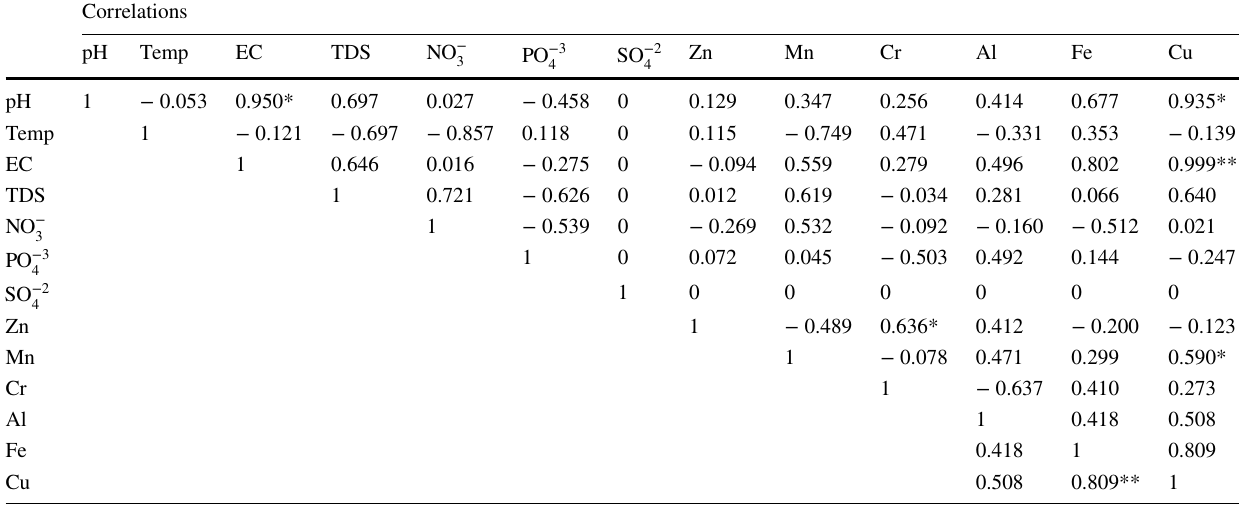
Table 3 Correlation matrix for the physiochemical parameter in water